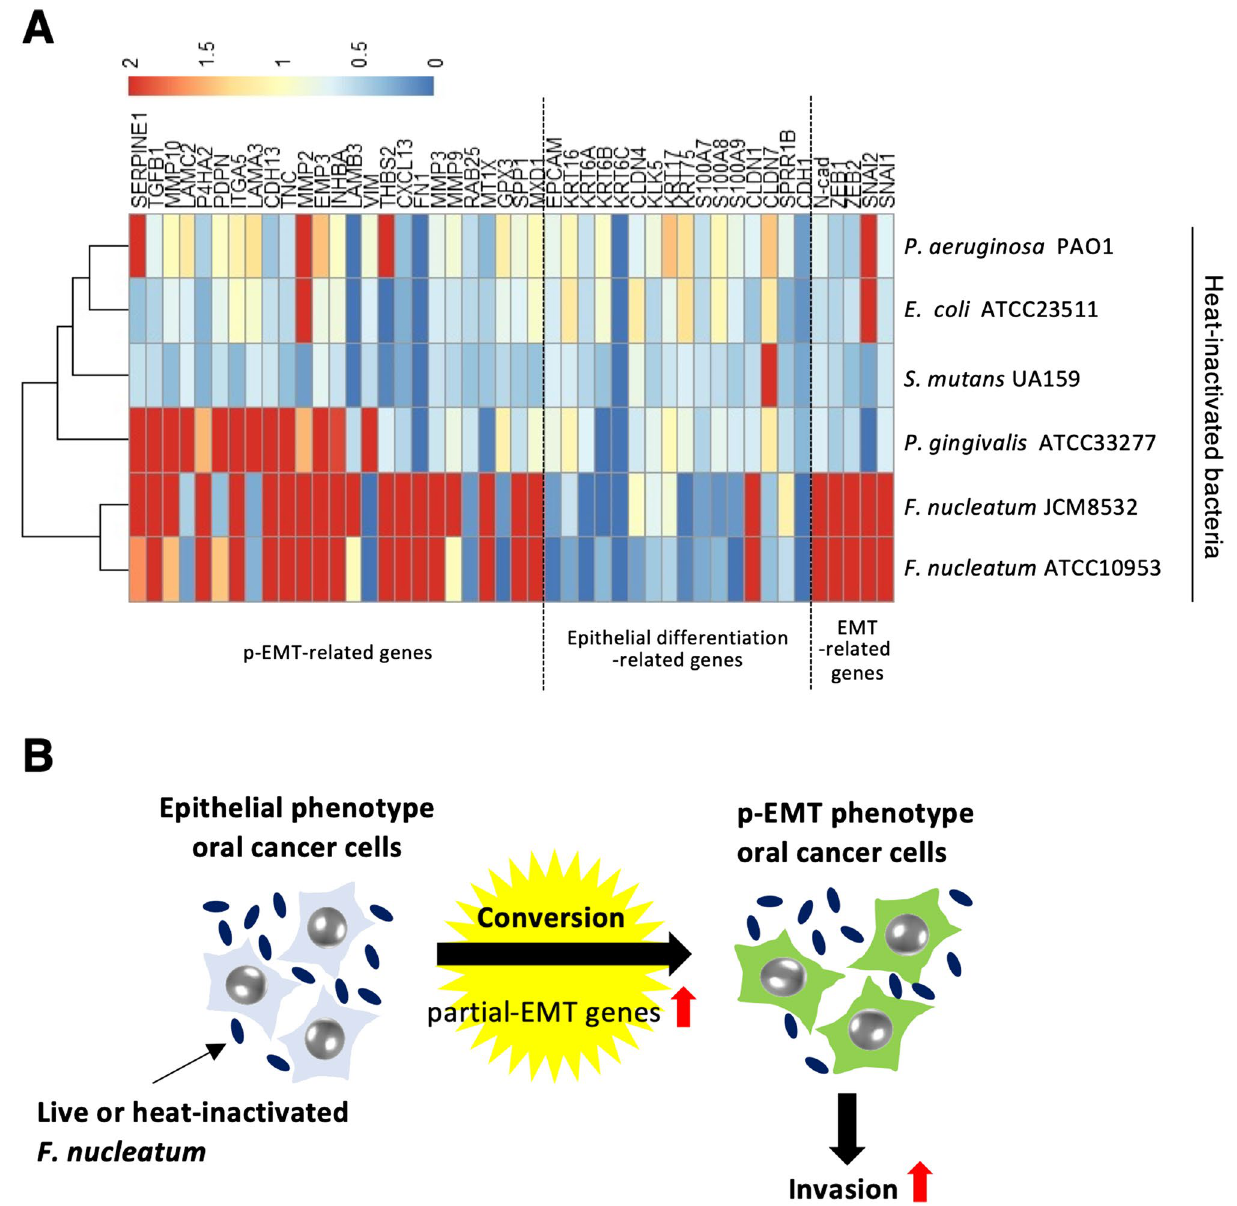
Figure 8. Remarkable upregulation of p-EMT-related genes by F. nucleatum in epithelial phenotype, HOC621 cells. ( A ) Heatmap shows the expression levels of epithelial differentiation-related, p-EMT-related, and EMT- related genes after co-culture with heat-inactivated F. nucleatum , P. gingivalis , S. mutans , P. aeruginosa , and E. coli in epithelial phenotype, HOC621 cells. Gene expression data is shown in Supplementary Fig. S8. ( B ) Schematic model showing that F. nucleatum promotes invasion of OSCC cells via conversion from epithelial to p-EMT